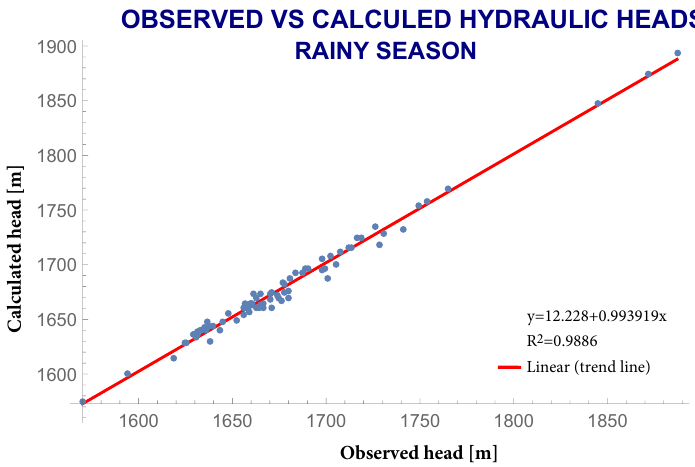
Figura 2.18: Correlaci´on de los niveles piezom´etricos observados y calculados en Temporada de Fig. 16. Correlation of observed and calculated piezometric levels in the Rainy Season Figure 15. Correlation of observed and calculated piezometric levels in the rainy Lluvias, 2015.